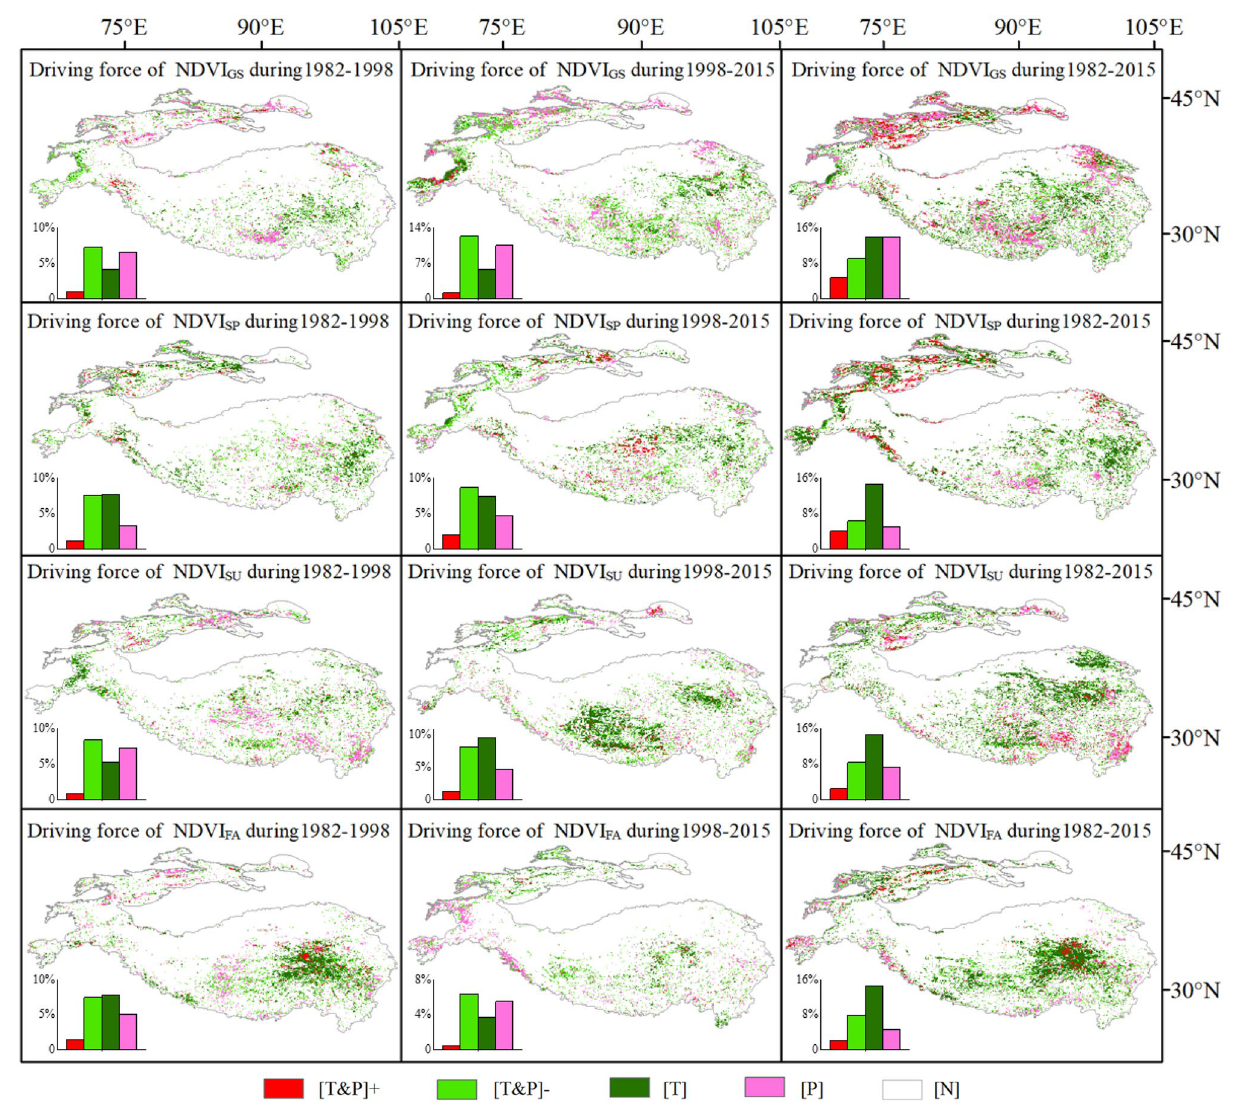
Figure 6. Spatial distribution of climate factors significantly affecting vegetation dynamics in HMA for growing seasons (GS), spring (SP), summer (SU) and fall (FA) from 1982 to 2015 (Generated by ArcGIS 10.3, URL: http:// www. esri. com/ softw are/ arcgis/ arcgis- for- deskt op, and Origin 2020b, URL: https:// www. origi nlab.